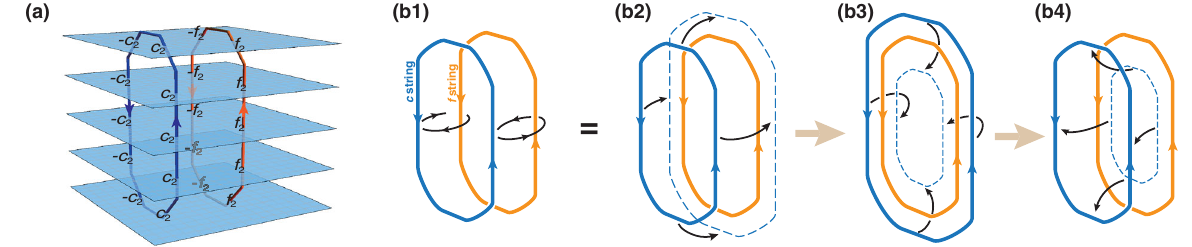
FIG. 9. (a) The definition of a c string (blue line) and an f string (orange line). Each plane represents a layer of the 2D topological state. The convention on the orientation of the string is explained in the main text. (b1) The braiding process of the two strings. (b2) – (b4) The braiding process shown in decomposed